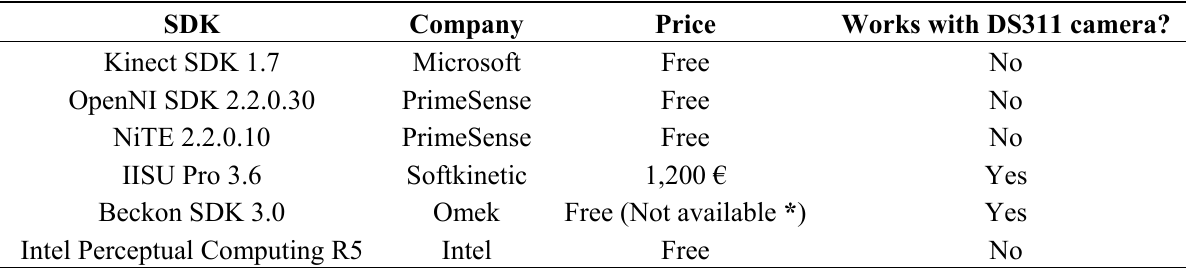
Table 2. Available tracking